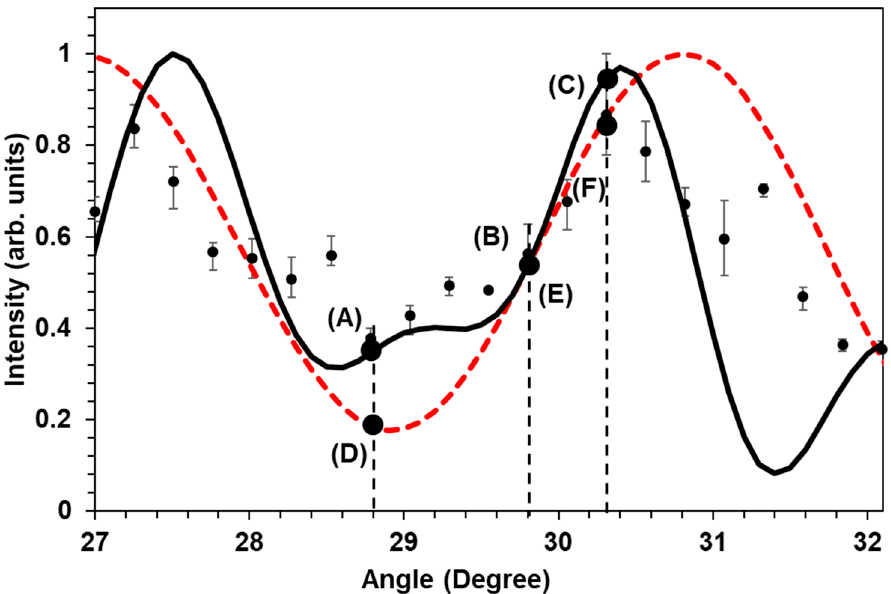
Figure 3. Intensity modulation of the AS3 sideband measured with the spectrometer after the second interaction region (FWM2 in Figure 1). The experimental data—dots with error bars, calculated profiles—solid line (for 5 sidebands) and broken line (for 3 sidebands).